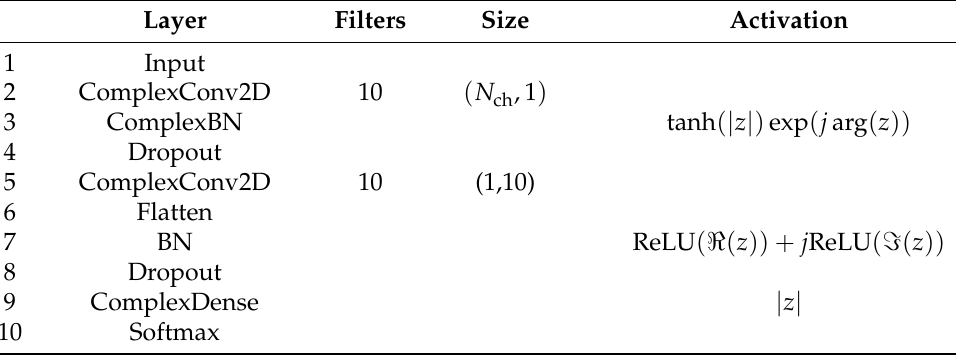
Table 1. Network structure of the proposed CNN: N ch is the number of channels, and BN is batch